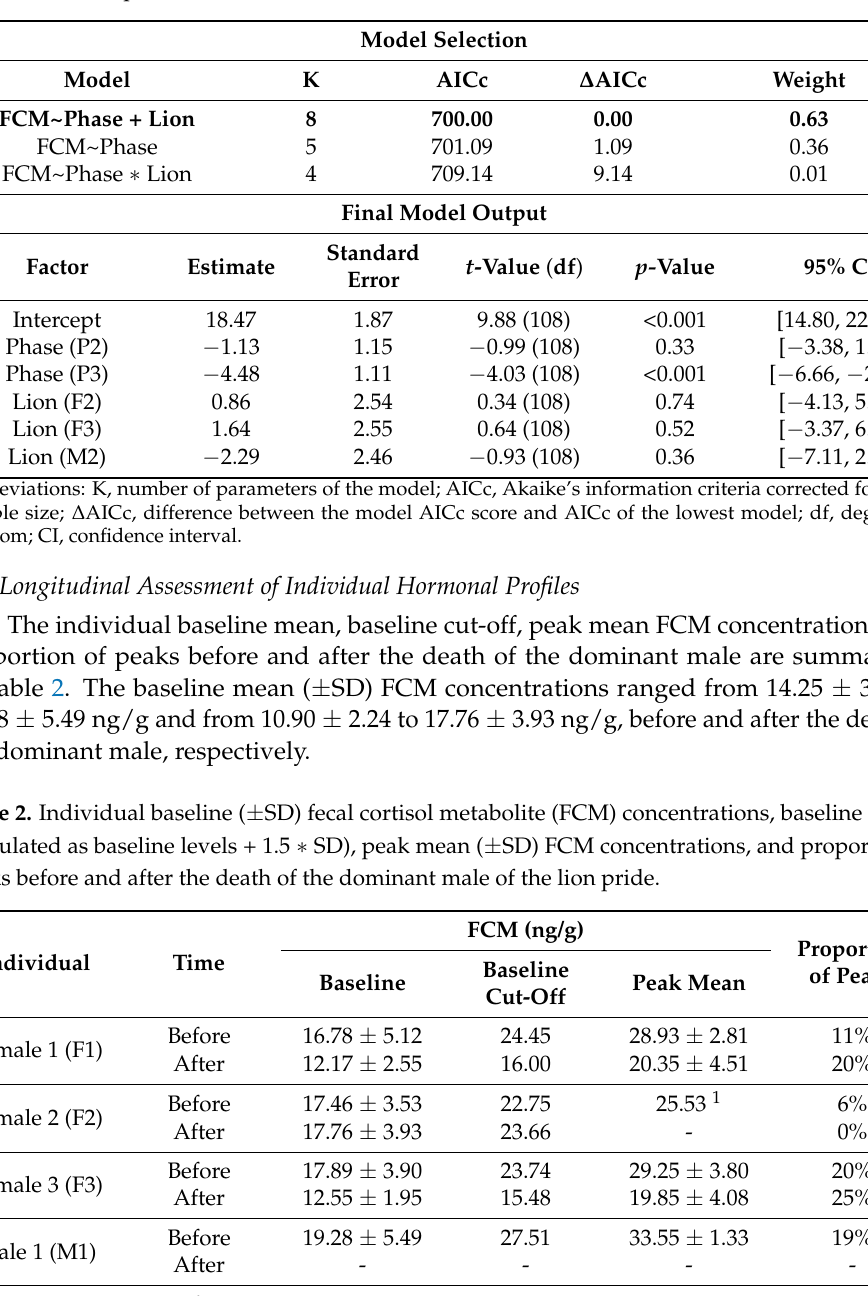
Table 1. Statistical results for the effect of phase and lion on the FCM concentrations, showing model selection based on Akaike’s information criteria corrected for small sample size and the best fit linear mixed model output. Selected model is denoted in bold.